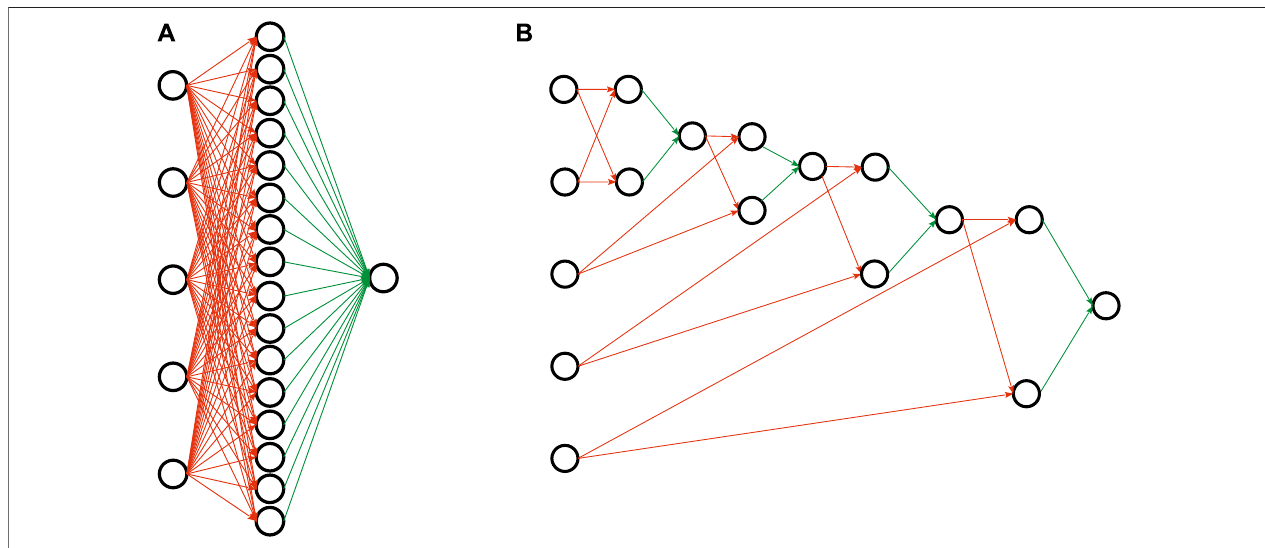
FIGURE 2 | Network representations of the parity rule sets of Figure 1 . Red connections are logical ANDs, green edges correspond to logical ORs. (A) Shallow representation. (B) Deep representation.